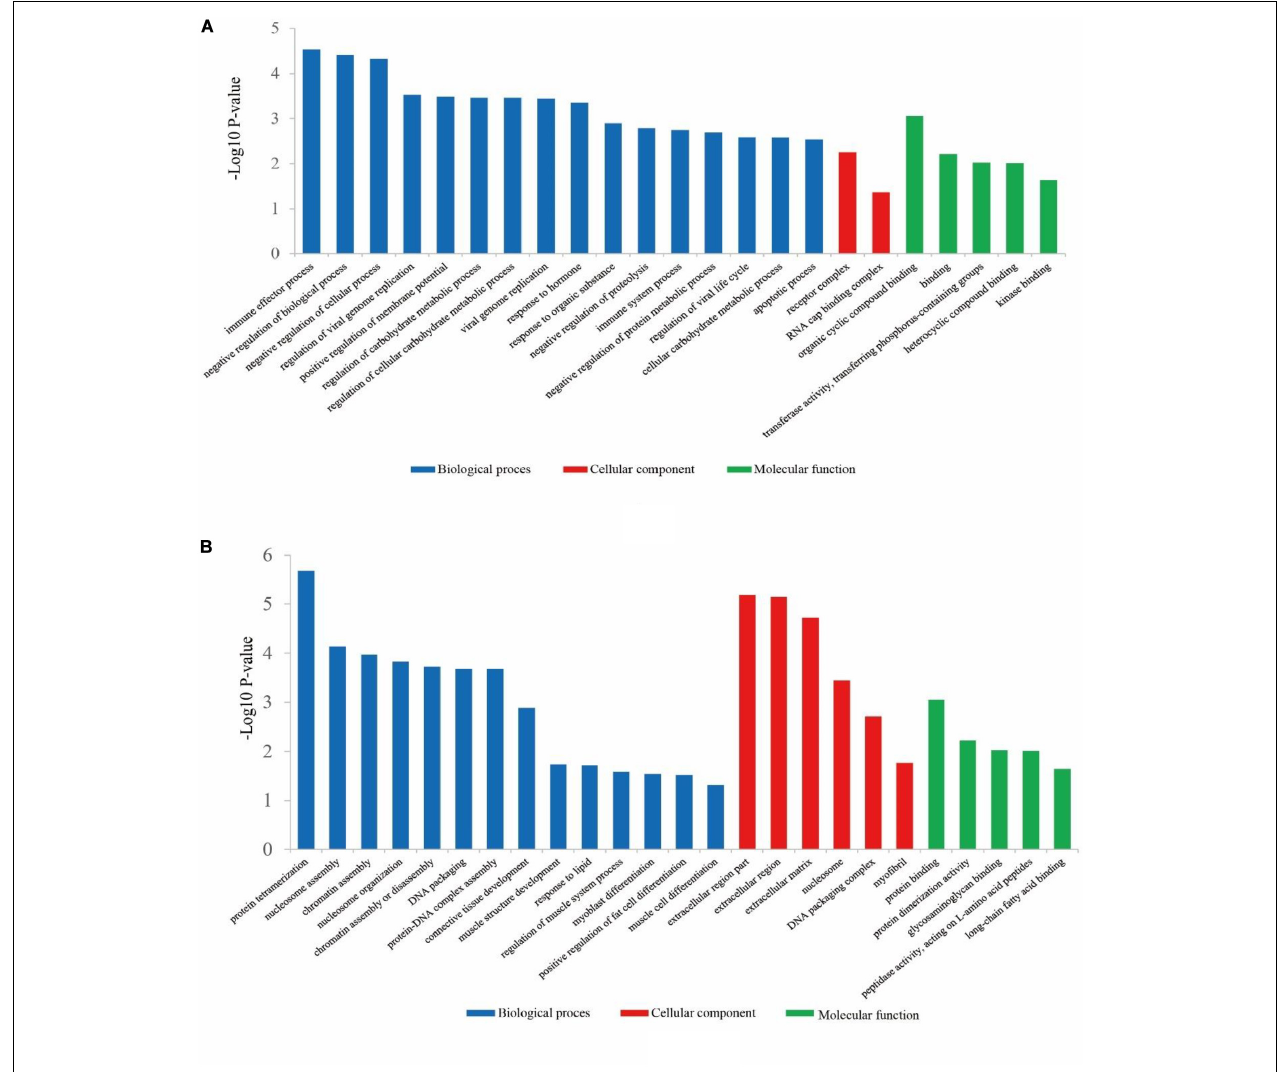
FIGURE 3 | The classification of Gene Ontology (GO) terms for up-regulated genes (A) and down-regulated genes (B) in ZB goats compared to LC goats. The most enriched biological process, cellular component and molecular function GO terms are shown.